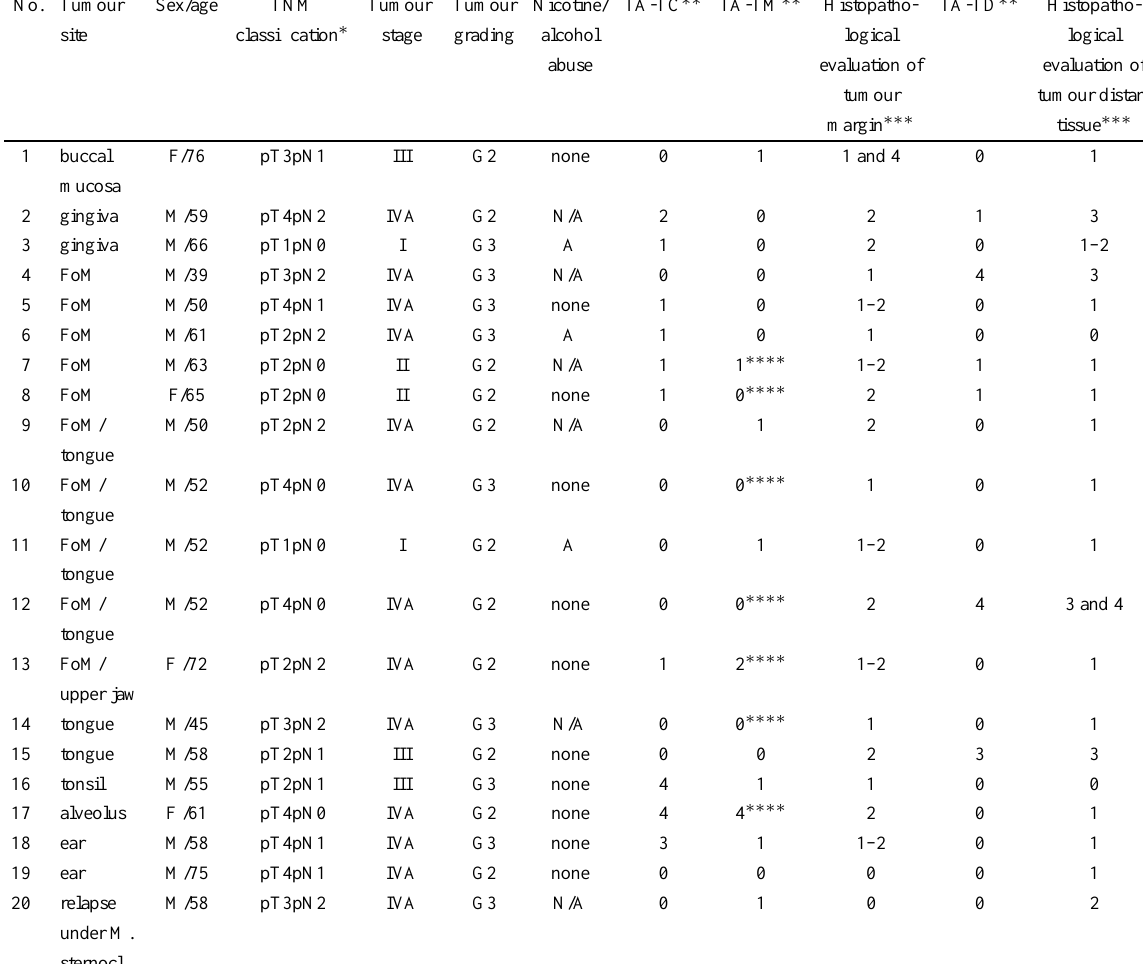
Telomerase activity (TA) of carcinoma tissue and carcinoma-free samples from 20 patients with head-and-neck squamous cell carcinoma and the clinical and histopathological details No.